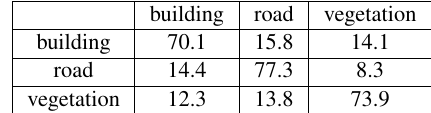
Table 4: The confusion matrix: pixelwise accuracy of the MSHCRF classification on the Beijing Airborne Data.